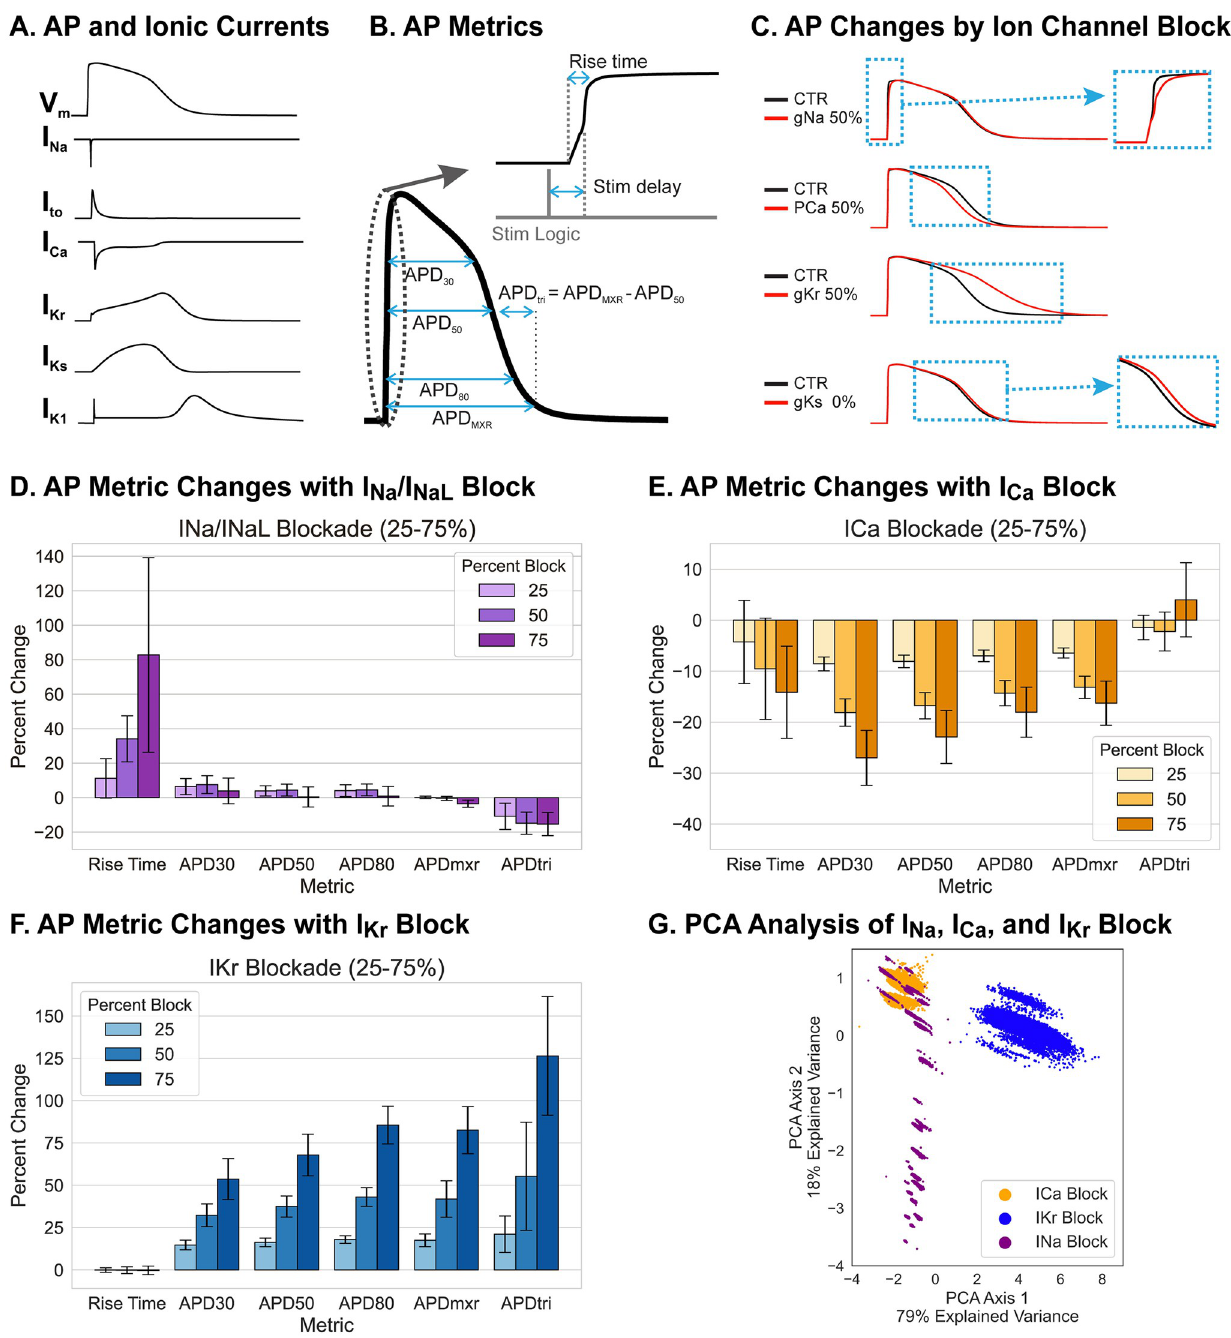
Fig 2. Selection of action potential metrics to detect ion channel block through computer modeling. (A) Human action potential model by O’Hara et al. [52] and the underlying major ionic currents: Na + (I Na ), transient outward K + (I to ), Ca 2+ (I Ca ), rapidly (I Kr ) and slowly (I Ks ) activating delayed rectifier K + currents, and inward rectifier K + current (I K1 ). (B) Illustration of AP metrics to detect AP shape changes by ion channel block; AP upstroke rise time, plateau phase (APD 30 and APD 50 ), and phase 3 repolarization (APD 80 , APD mxr , and APD tri = APD mxr − APD 50 ). (C) Modeling of AP changes in response to specific block of indicated ion channels to 50% conductance (gX 50%). I Na block exclusively alters AP upstroke; I Ca block shortens APD by depressing the plateau V m which accelerates repolarization; I Kr block slows the phase 3 repolarization; and I Ks block slightly prolongs APD. (D-F) Simulated changes in AP metrics following specific blocking of three major ionic currents (I Na , I Ca , and I Kr ) at 25%, 50% and 75%. Details of the modeling and parameter sets are described in Methods. (G) PCA plot of I Na , I Ca , I Kr block. Feature extraction was done using principal component analysis (PCA). Distributions of AP metric changes are shown for I Na (purple), I Ca (orange), and I Kr (blue) at 75% block. PCA indicates two major features that best distinguish AP metric changes between the five simulated blocks (I Na , I Ca , I Kr , I to , and I Ks ; see Tables 1 and 2).